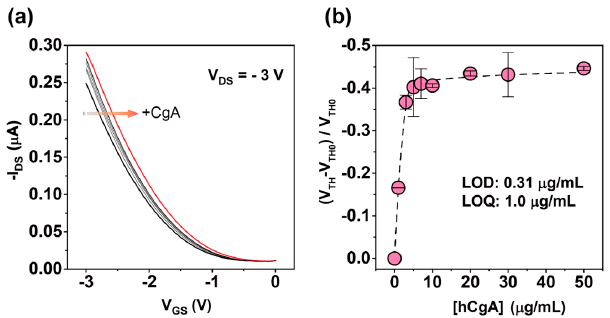
Figure 2. ( a ) Transfer characteristics ( I DS - V GS ) of the OFET upon titration with hCgA in a PBS solution with 0.1 wt % HSA. [Human CgA] = 0, 1, 3, 5, 7, 10, 20, 30, and 50 µg/mL; ( b ) Changes in the threshold voltage ( V TH ) of the OFET by hCgA at various concentrations in a PBS solution with 0.1 wt % HSA. Five repetitions were measured for each concentration.